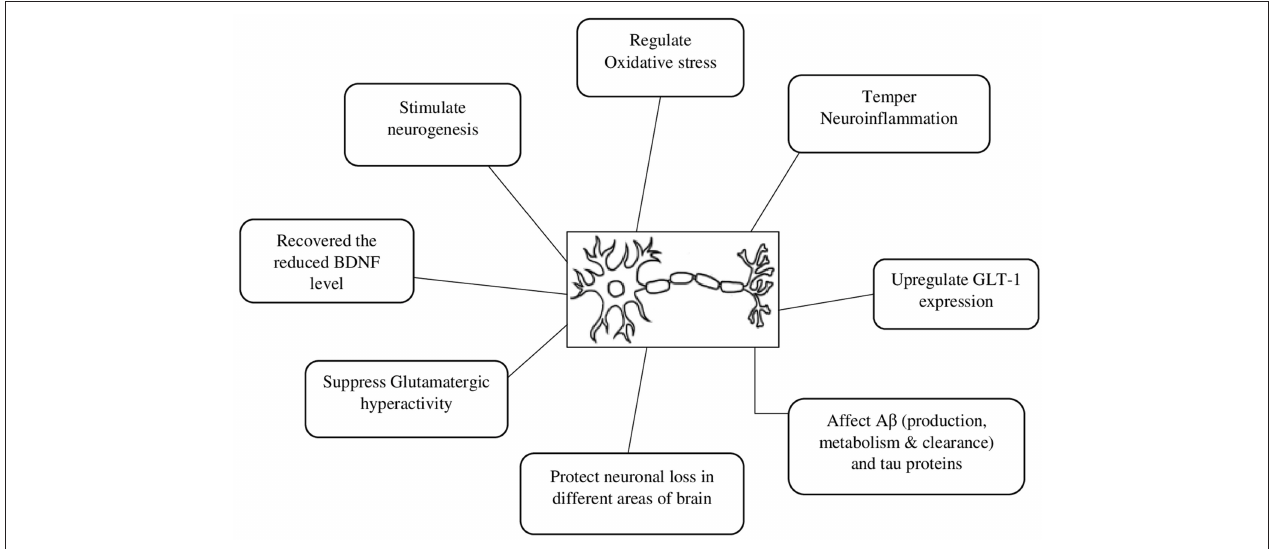
FIGURE 1 | Possible neuroprotective mechanisms of ceftriaxone. A β , beta amyloid protein; BDNF, brain-derived neurotrophic factor; GLT 1, Glutamate transporter